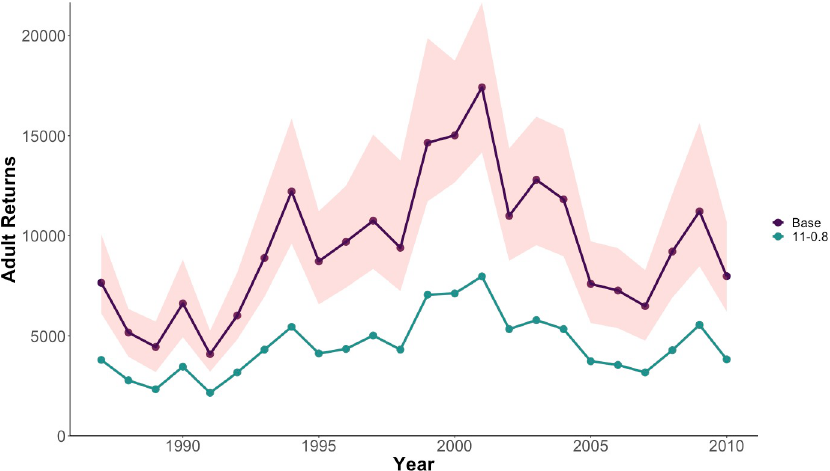
Fig 3. Simulated abundance of adult Chinook salmon returns in the Salcha River indicator stock plotted with (scenario 11–0.8) and without (base) additional mortality. Note how the scenario causes the adult return to fall outside of the 95% Bayesian credible interval (shaded area) of the original model